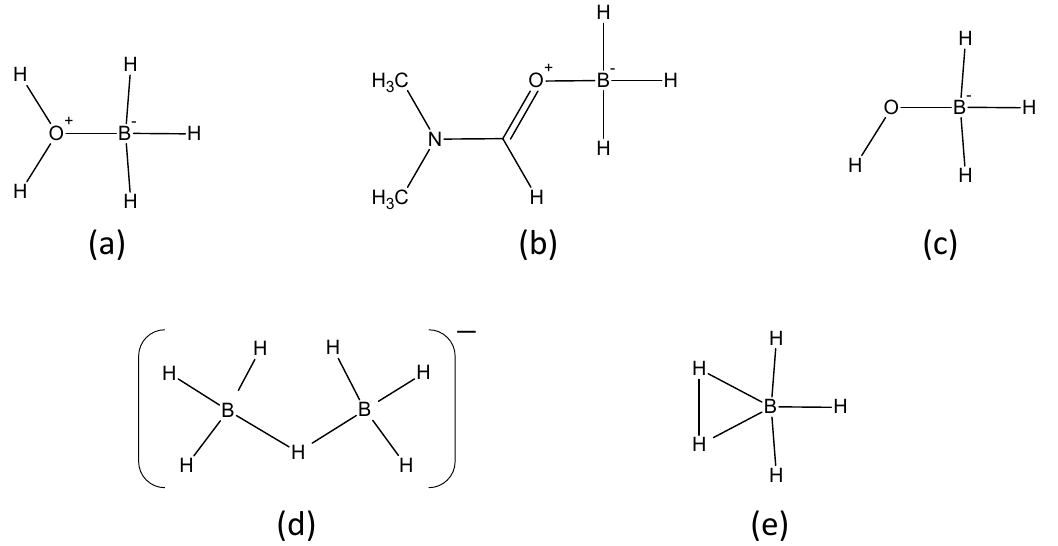
Figure 5. Possible BH 3 intermediates showing a quartet in 11 B NMR: ( a ) H 2 O · BH 3 , ( b ) DMF · BH 3 , ( c ) BH 3 OH − , ( d ) B 2 H 7 − , and ( e ) BH 3 (H 2 ). Table 2. Chemical shifts ( δ , in ppm) for the hypothetic BH 3 -based short-living intermediates plus that of BH 4 − for comparison as calculated using Gaussian 09 and CASTEP. The experimental values for the experiment (c) are recalled, where I 1 is proposed to be DMF · BH 3 , and I 2 to be B 2 H 7 − .